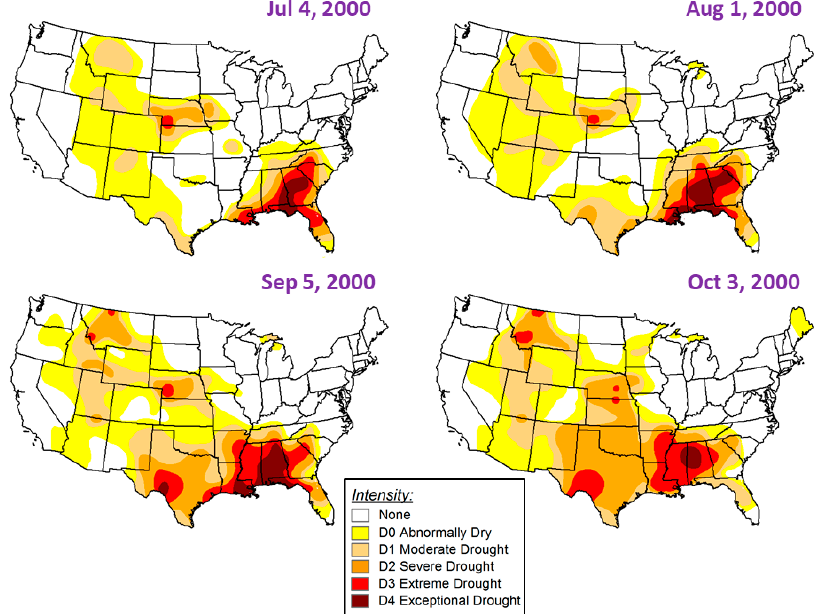
Figure 6. USDM maps on July 4 ( top left ), August 1 ( top right ), September 5 ( bottom left ), and October 3 ( bottom right ) in Year 2000.